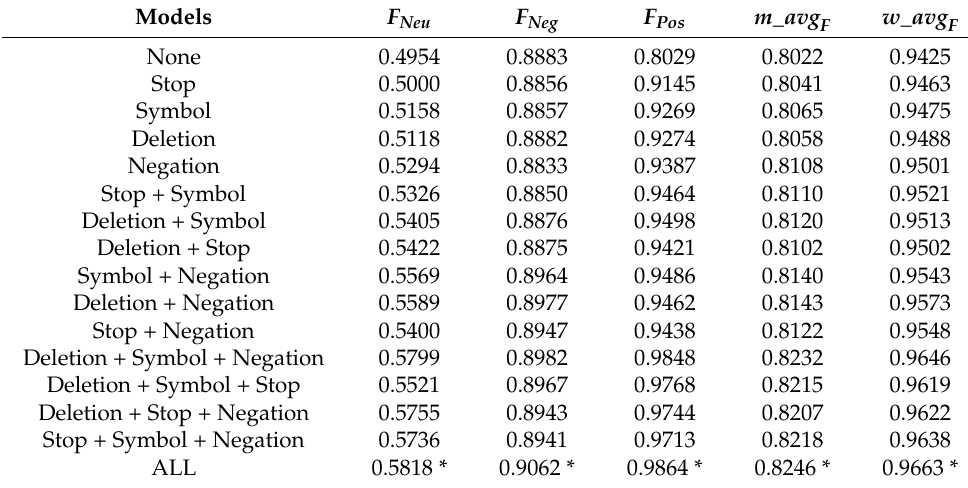
Table 3. Ablation experimental results on performance